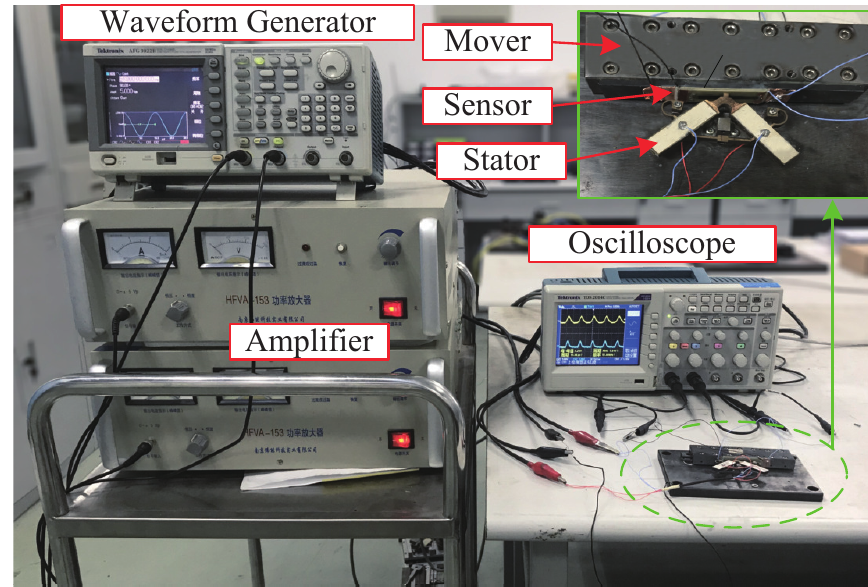
Figure 14. Measurement system for the stator–mover dynamic